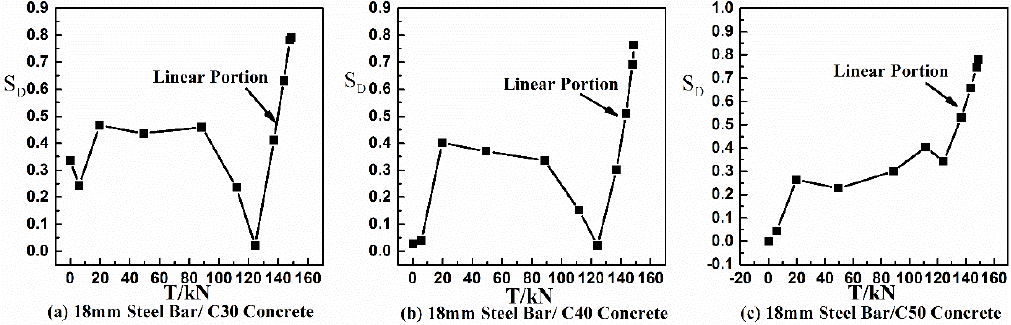
Figure 11. S D – T diagrams of the axial scanning test curves for the SBCC specimens.